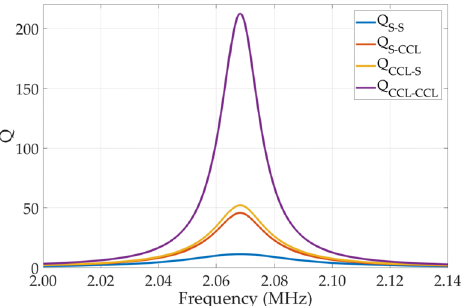
Figure 8. Comparison of Q factors among S–S, S–CCL, CCL–S, and CCL–CCL system topologies.